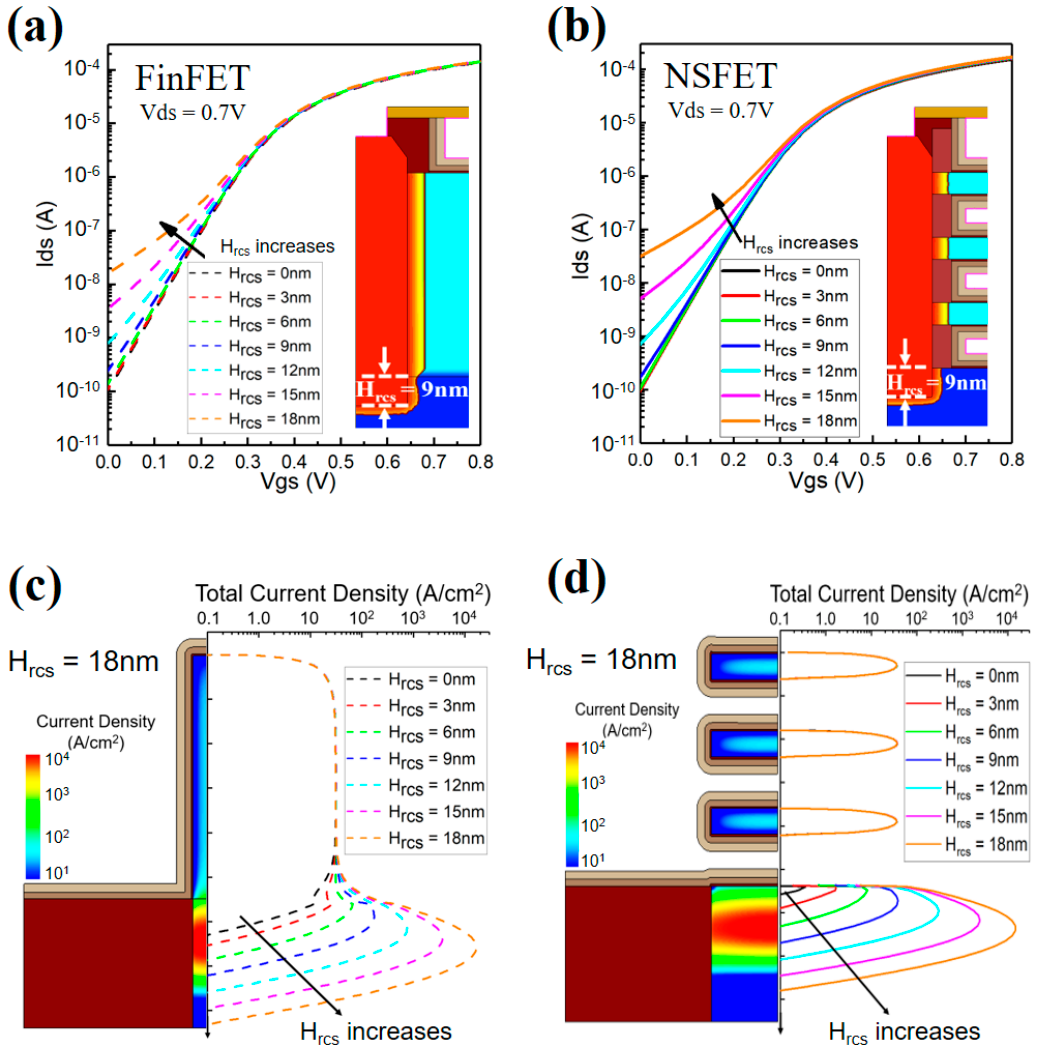
Figure 6. ( a ) Id-Vg curves @ Vds = 0.7V with various H rcs from 0 nm to 18 nm for ( a ) Fin and ( b ) NS FETs. Leakage current density contour plots at H rcs = 18 nm and its variation along Fin height direction of ( c ) Fin and ( d ) NS FETs.